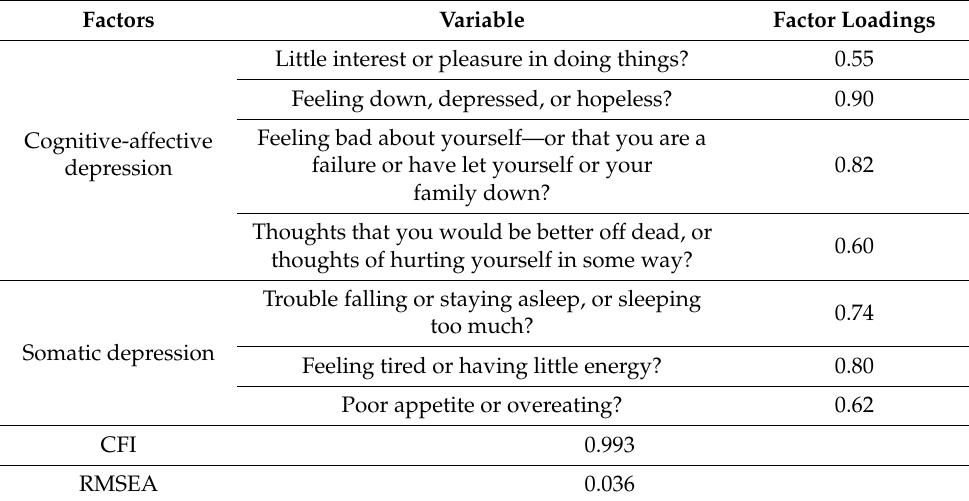
Table 1. Confirmative factor model on the PHQ-9 module. n = 144. Factors Variable Factor